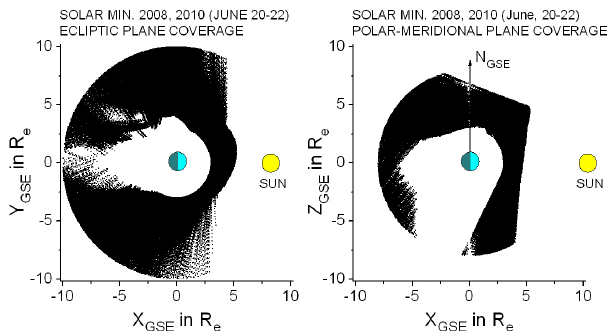
Figure 7. LOS Lyman- α intensities against their Earth impact pa- rameters. Intensities on the right figure (solar maximum) are plotted scaled with the ratio of solar Lyman- α fluxes at 20 June 2008 and at each specific period as expressed in Eq. (5).